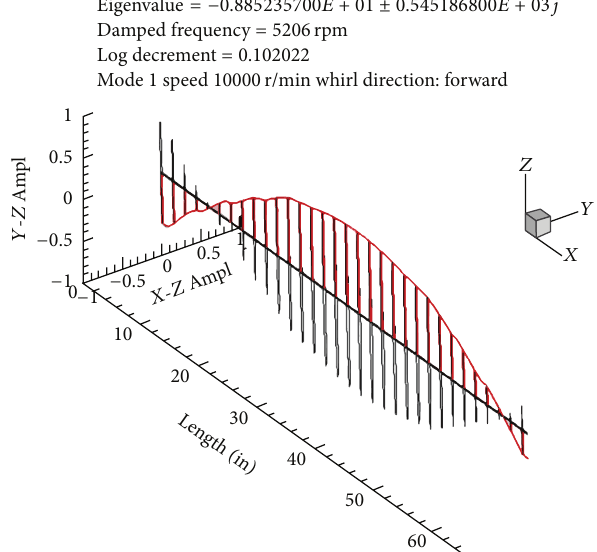
Figure 7: FEM model of the stability test rig rotor.